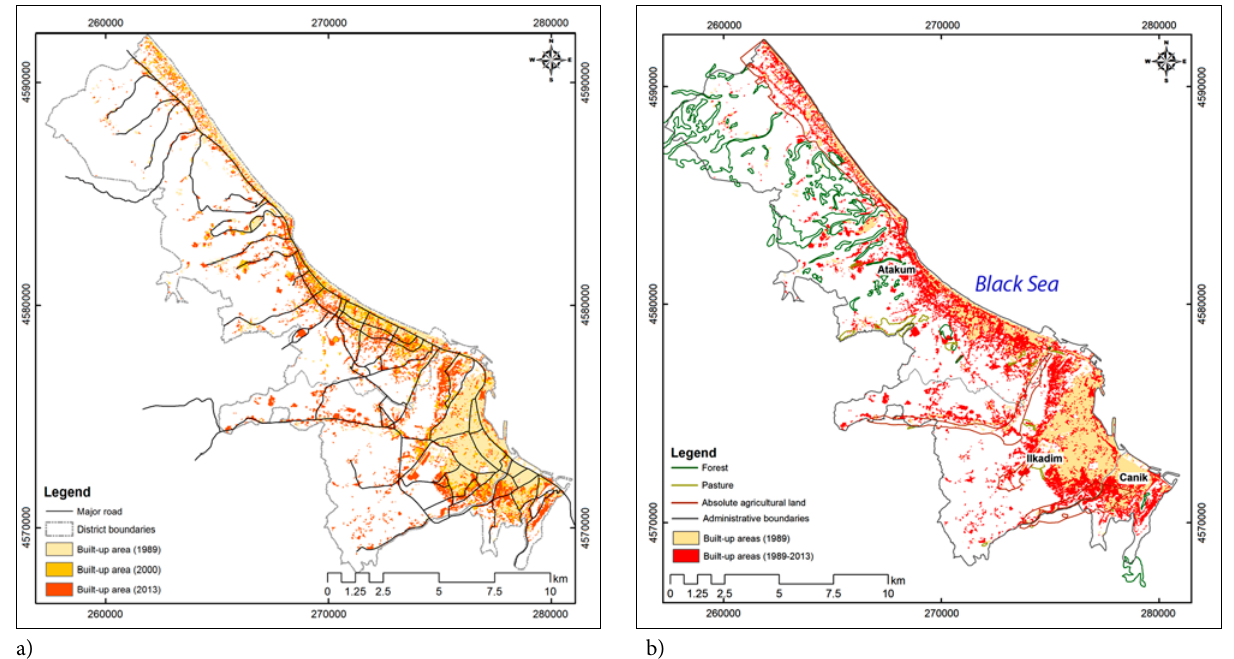
a) Fig. 7. (a) Spatial distribution of the major road network and extent and distribution of the built-up areas. It can be seen that urban sprawl occurs along roads. (b) The transition to built-up areas via the destruction of forests, absolute agricultural land and pastures